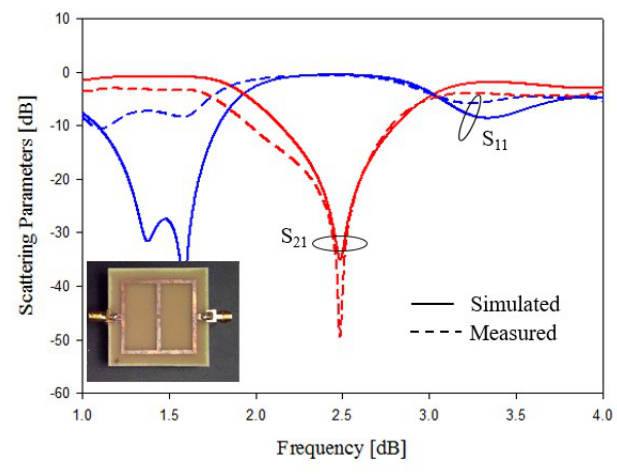
Figure 12. Experimental assessment, prototype of Figure 11a. Comparisons between numerical and measured scattering